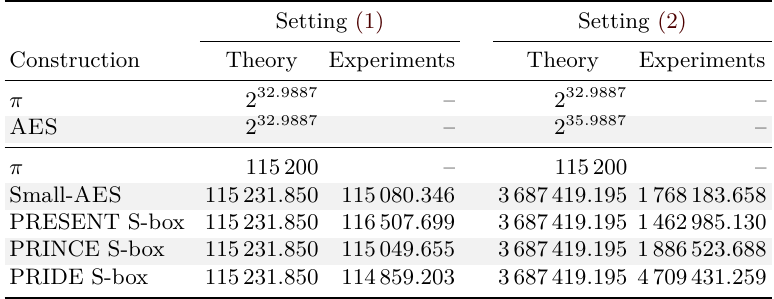
Table 9: Summary of the variances for our four-round distinguisher. RP = random permutation. Exp. = experiments from 100 000 random keys with 2 14 δ -sets